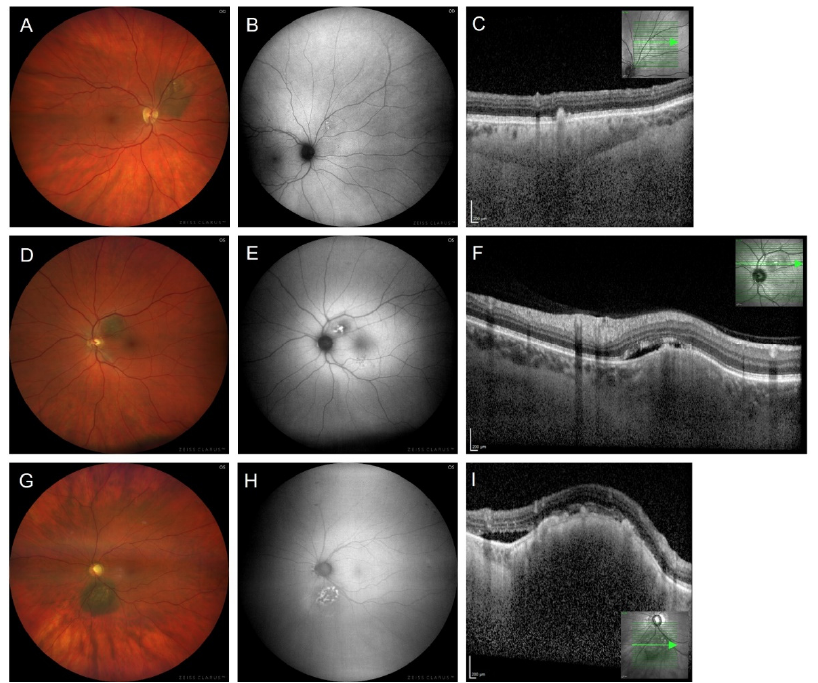
Figure 3. ( A – C ) Imaging of a choroidal nevus and ( D – I ) of small choroidal melanomas. ( A ) Fundus photograph and ( B ) fundus autofluorescence image of a choroidal nevus in a 61-year-old female. Only mild changes of the normal fundus autofluorescence signal occur. ( C ) A corresponding SD- OCT scan shows drusen but does not reveal any subretinal fluid. Prominence in ultrasound measurements (not shown) was <1 mm. ( D – F ) Small choroidal melanoma in a 56-year-old male patient with tumour height being <1 mm (ultrasonography not shown). ( G – I ) Small choroidal melanoma in a 56-year-old male with a tumour height of 1.35 mm (ultrasonography not shown). ( E , H ) Fundus autofluorescence shows a markedly increased signal due to orange pigment concomitant with areas of decreased autofluorescence overlying the choroidal melanoma. ( F , I ) On corresponding SD-OCT scans, subretinal fluid and retinal pigment epitheliopathy are found. Images were taken using ( A , B , D , E , G , H ) the ZEISS CLARUS 700 (Carl Zeiss Meditec AG, Jena, Germany) and ( C , F , I ) the SPECTRALIS OCT (Heidelberg Engineering, Heidelberg, Germany). ( B , E , H ): illumination with 500–585 nm (FAF-Green).